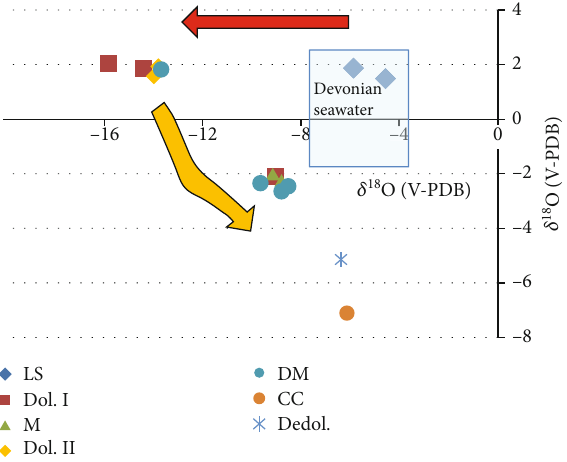
Figure 8: Cross-plot of ẟ 18 O (V-PDB) versus ẟ 13 C (V-PDB) of limestone (LS), dolomite (Dol. I and Dol. II), marble (M) and dolomitic marble (DM). Dashed blue box indicates the range of Devonian seawater according to [61]. Red arrow shows the temperature e ff ect while the yellow arrows show the e ff ect of sur fi cial fl